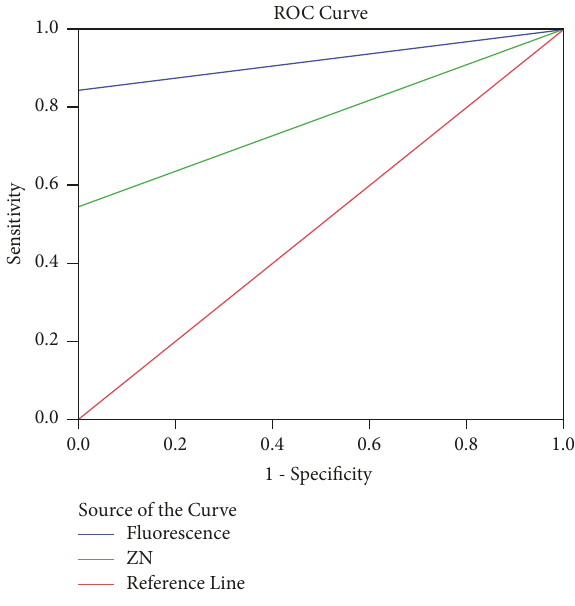
Figure 1: Receiver operator characteristic